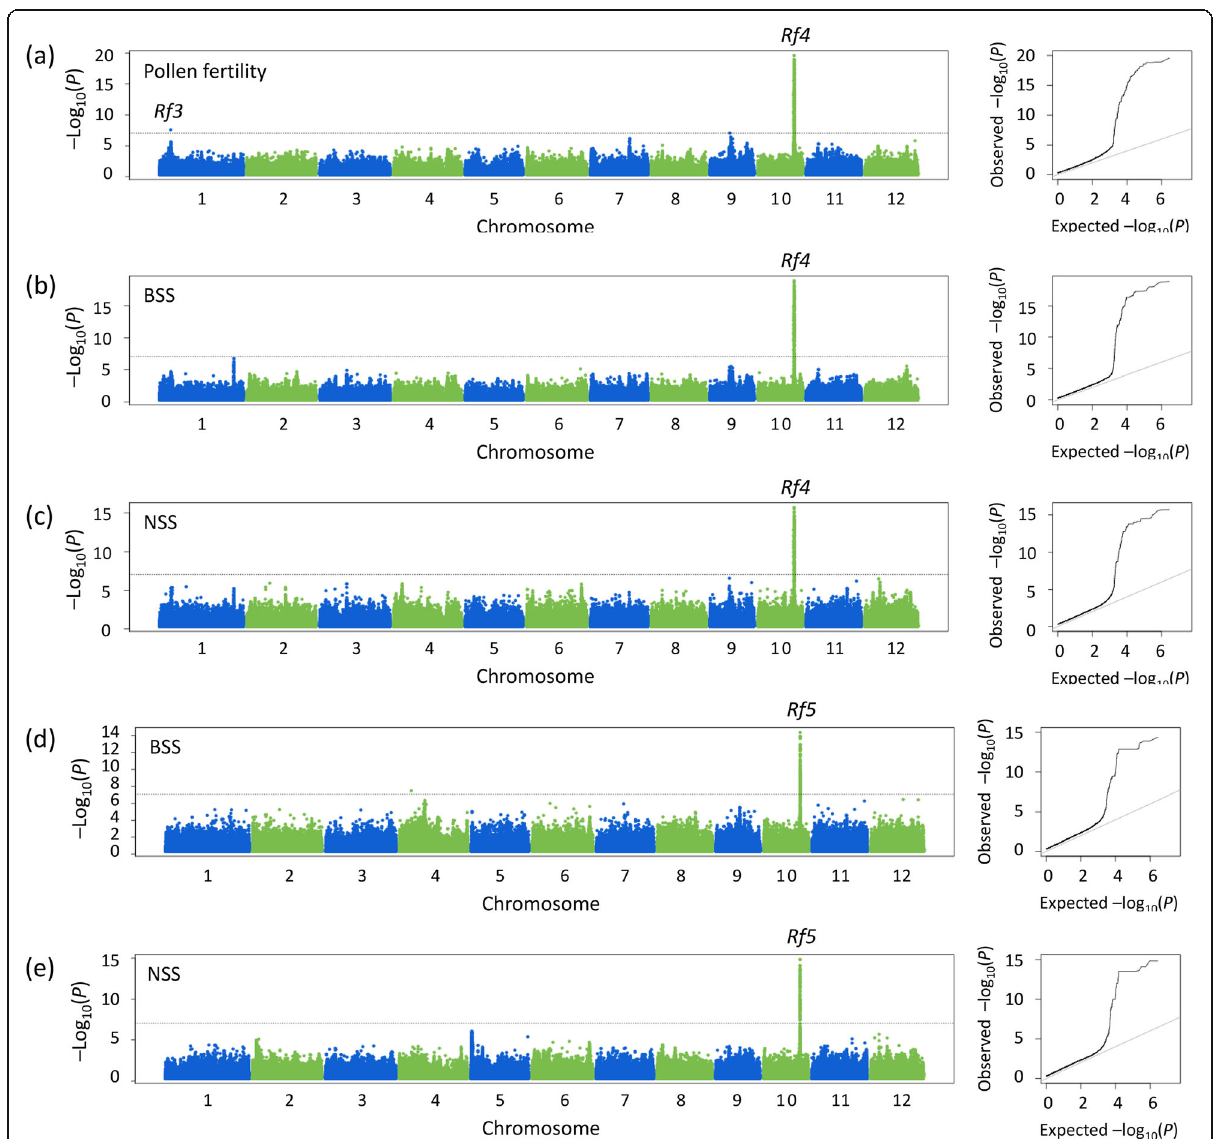
Fig. 4 Manhattan plots and quantile-quantile plots of pollen fertility ( a ), BSS ( b ) and NSS ( c ) of the F 1 population with the background of CMS- WA, and BSS ( d ) and NSS ( e ) of the F 1 population with the background of CMS-HL, in year 2014. Negative log 10 -transformed P values from a genome-wide scan are plotted against position on each of 12 chromosomes. Black horizontal dashed line indicates the genome-wide significance